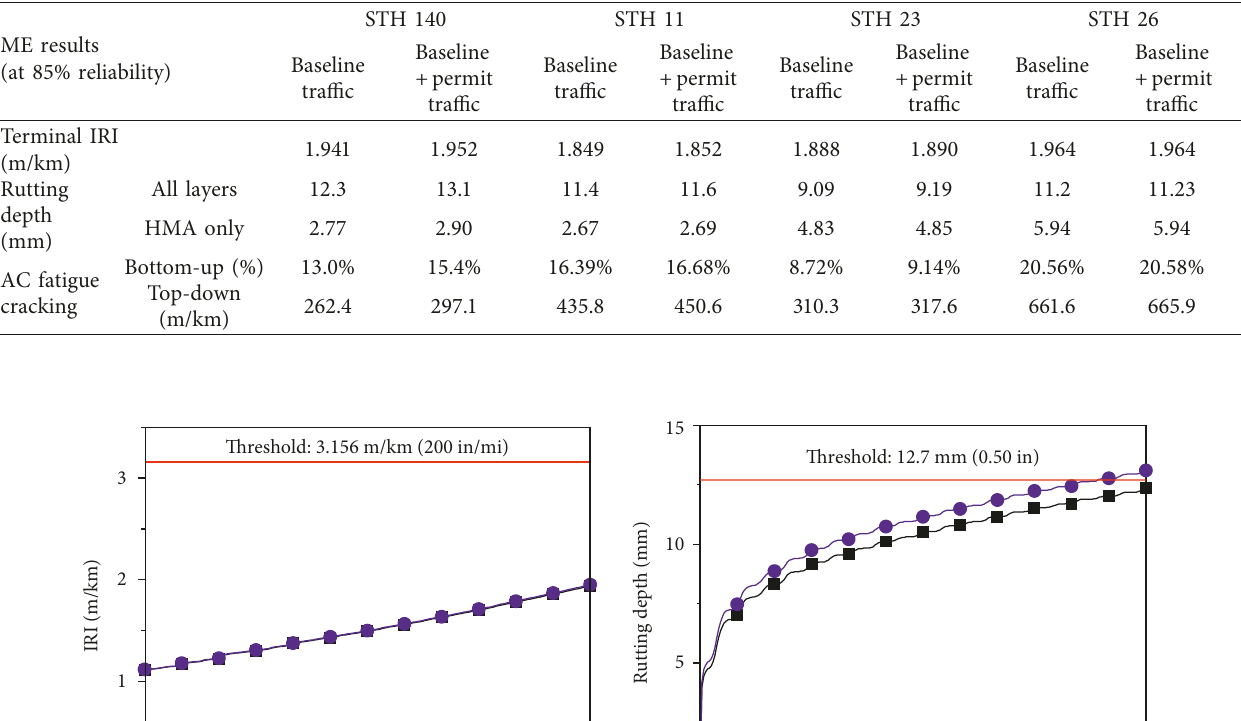
Table 4: ME analysis results at investigated test sites.